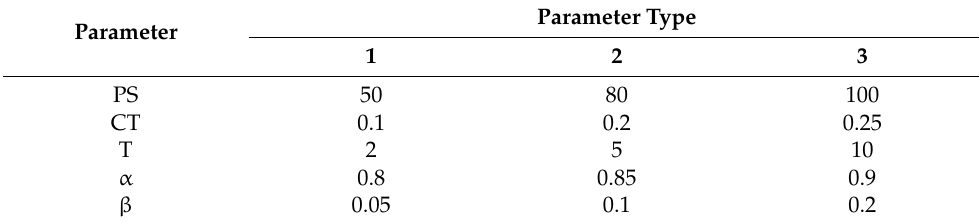
Figure 4. Comparison of weight adaptive adjustment times of M-E-AWA and MOEA/D-AWA algorithms when the maximum number of iterations is 20,000. Table 10. Parameters